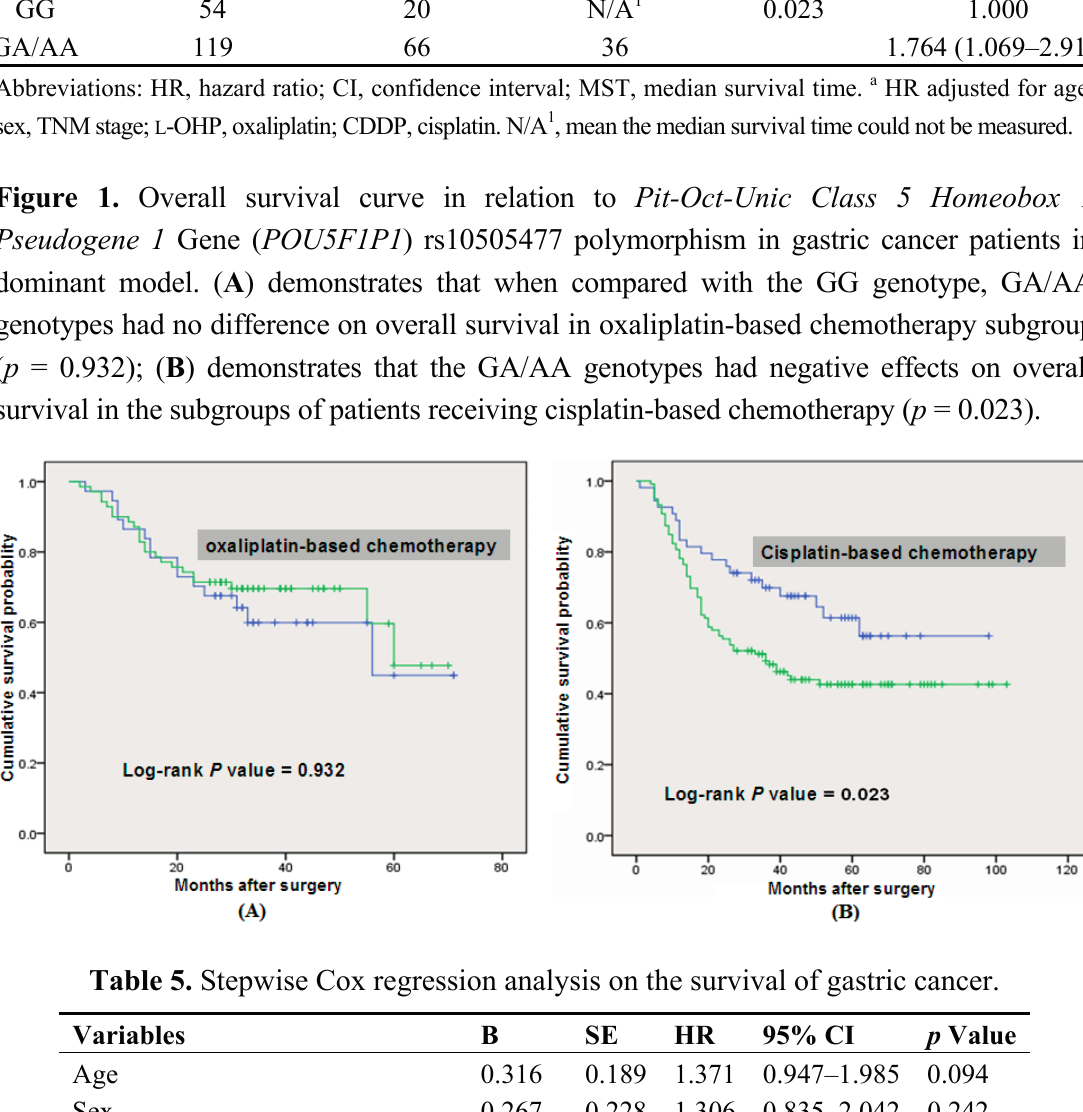
Figure 1. Overall survival curve in relation to Pit-Oct-Unic Class 5 Homeobox 1